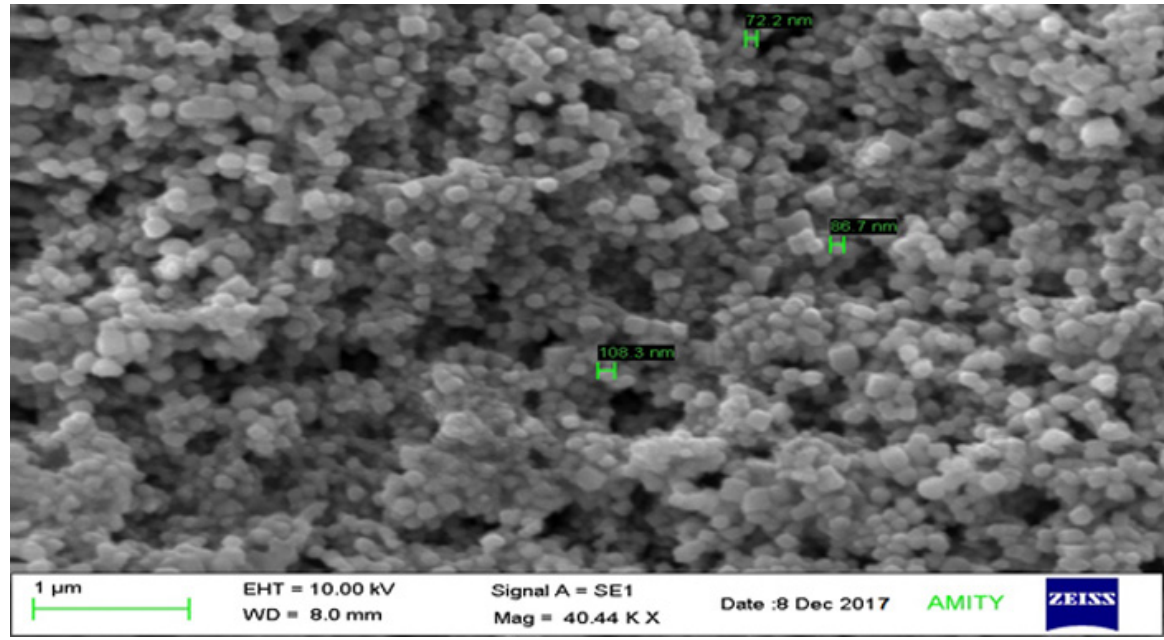
Figure 6: SEM image of synthesized CuO NPs at obtained optimum